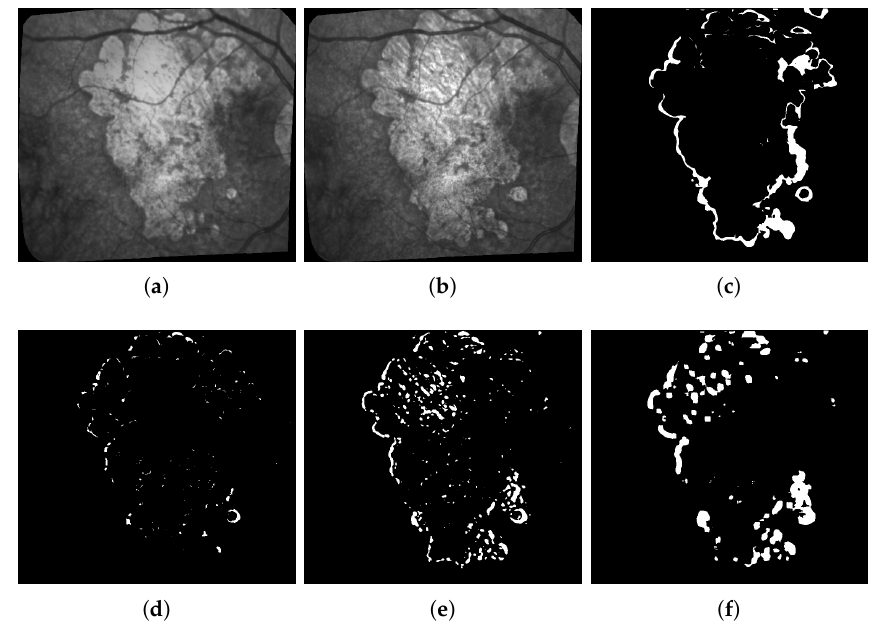
Figure 9. Comparison example of the three methods on patient 005. ( a ) Corrected Image from October 2017; ( b ) Corrected Image from June 2018; ( c ) Proposed ground truth; ( d ) Asako Kanezaki’s approach, F1 score = 0.15; ( e ) Turgay Celik’s approach, F1 score = 0.35; ( f ) Our Fully Convolutional AE, F1 score = 0.4.